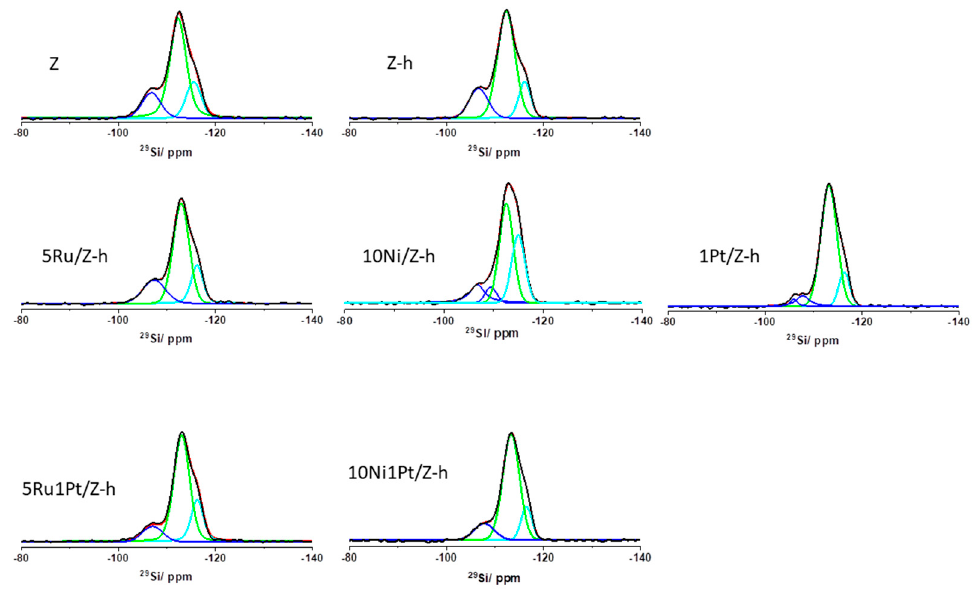
Figure 7. Experimental (black) and simulated (red) single-pulse 29 Si NMR spectra of the studied zeolites. The individual contributions of the different Si environments are given with colored lines (green, blue and cyan). Table 2. Area of the signals of the different Si and Al species, obtained by deconvolution of the spectral patterns in the 29 Si and 27 Al